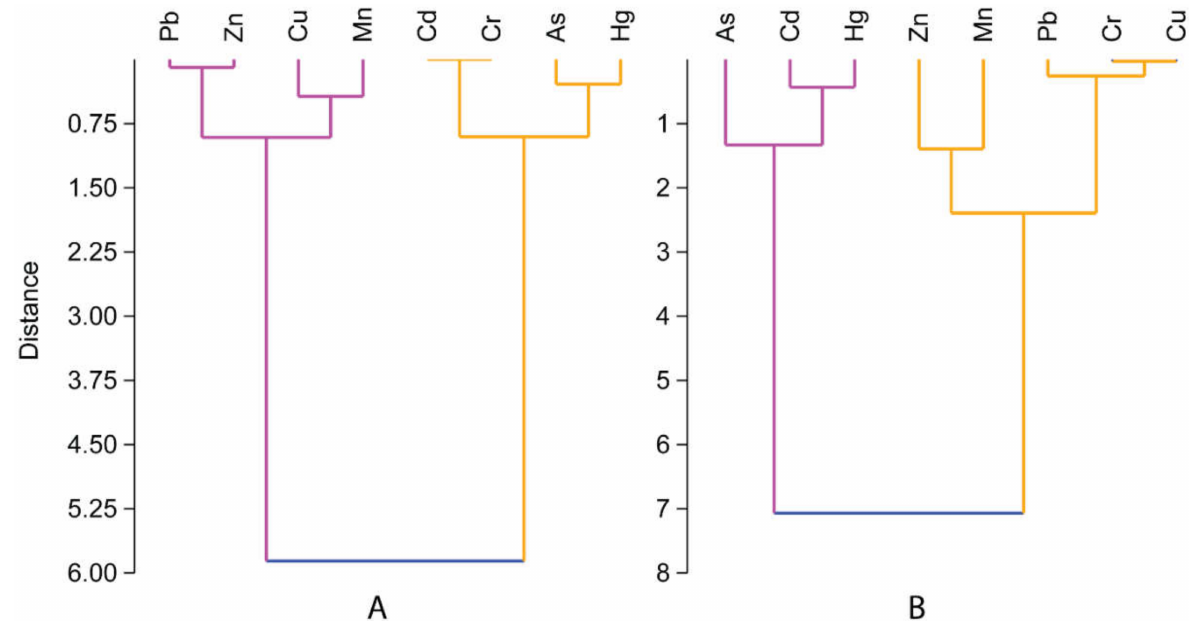
Figure 5. Hierarchical cluster dendrogram (Ward–Linkage method) of metal concentrations obtained from shrimp tissue ( A ) and farm sludge ( B